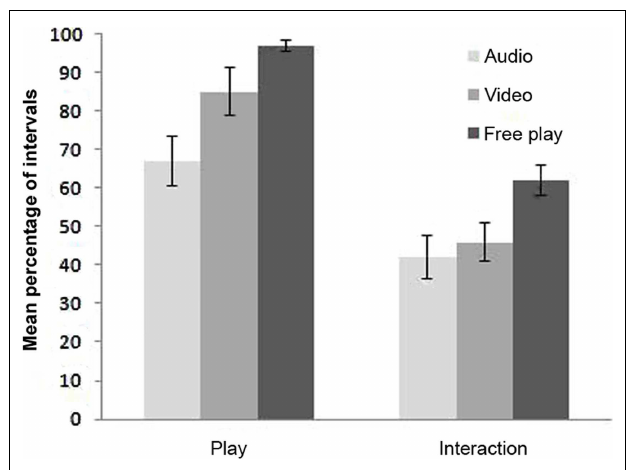
FIGURE 1 | Mean percentage of play and interaction during the free-play and separation